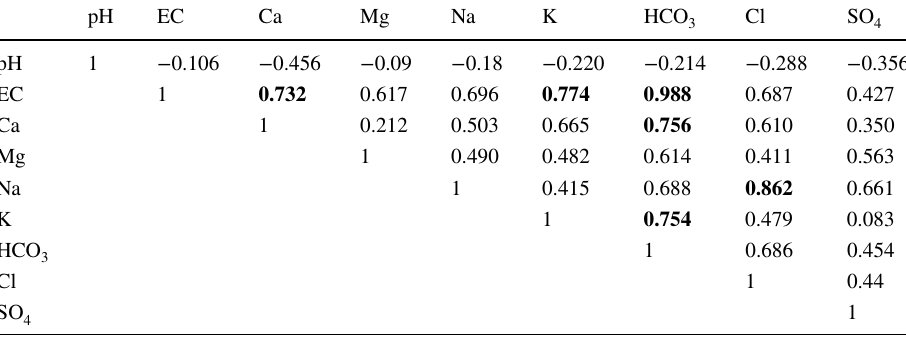
Boldface are the values that exceed the limit